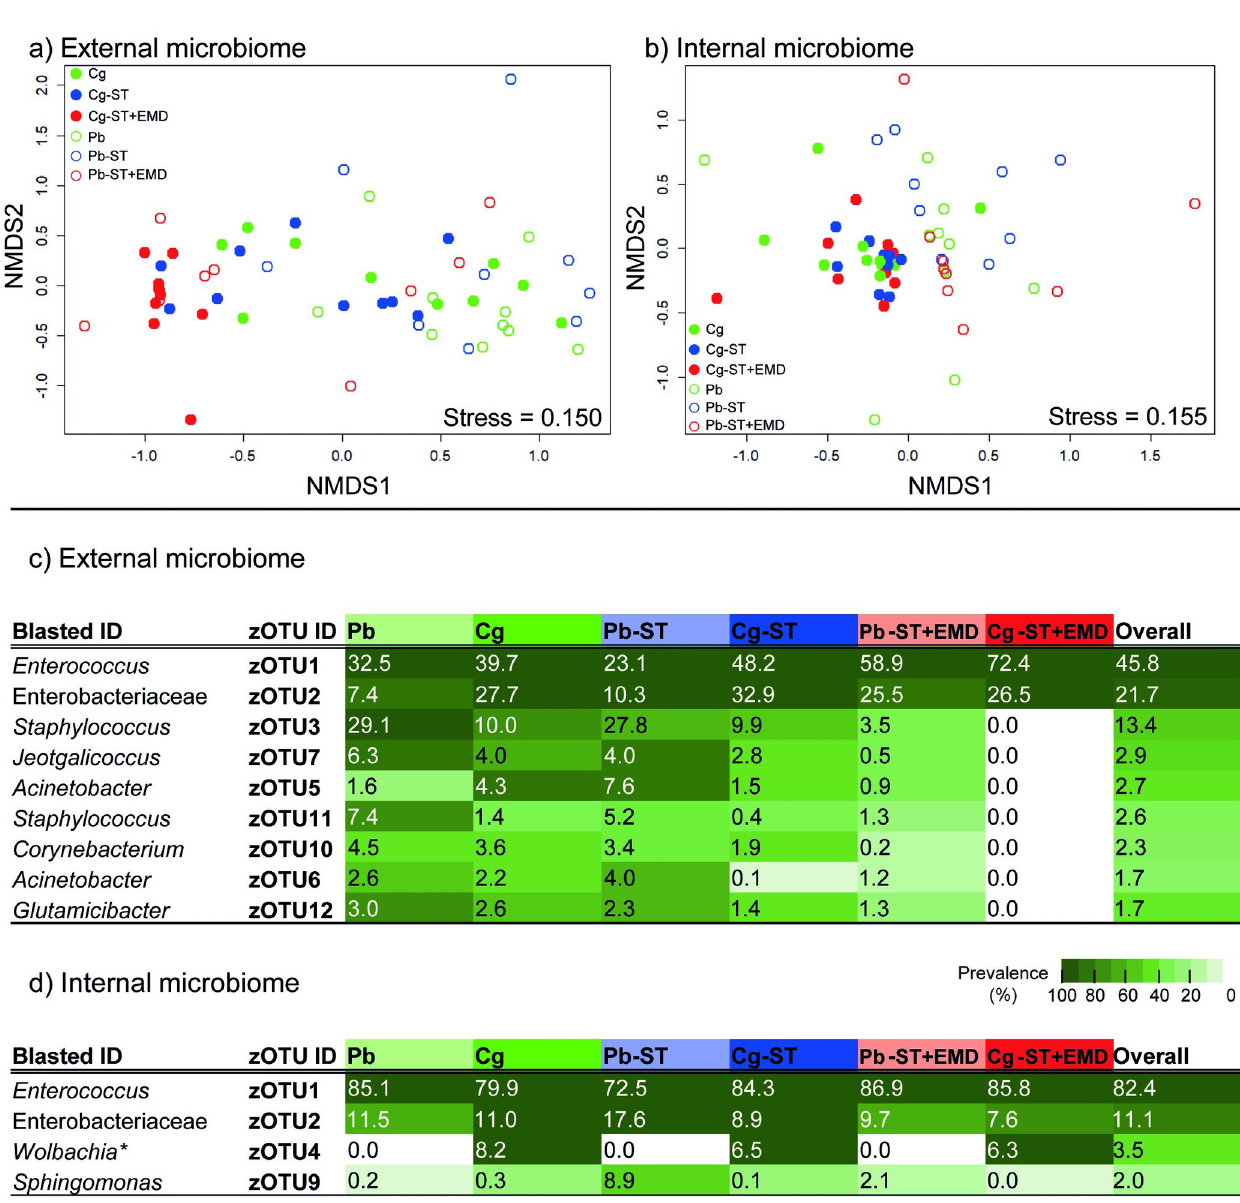
PLOS Pathogens| https://doi.org/10.1371/journal.ppat.1011262 March 22,